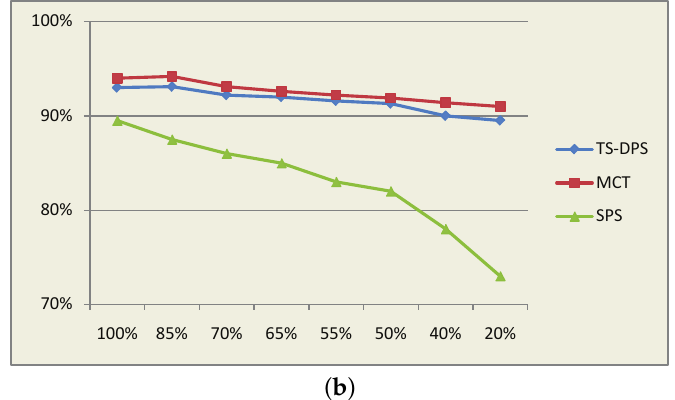
Figure 16. Comparison of the measured efficiency of the DBSRC under different control schemes: ( a ) M = 0.96; ( b ) M =